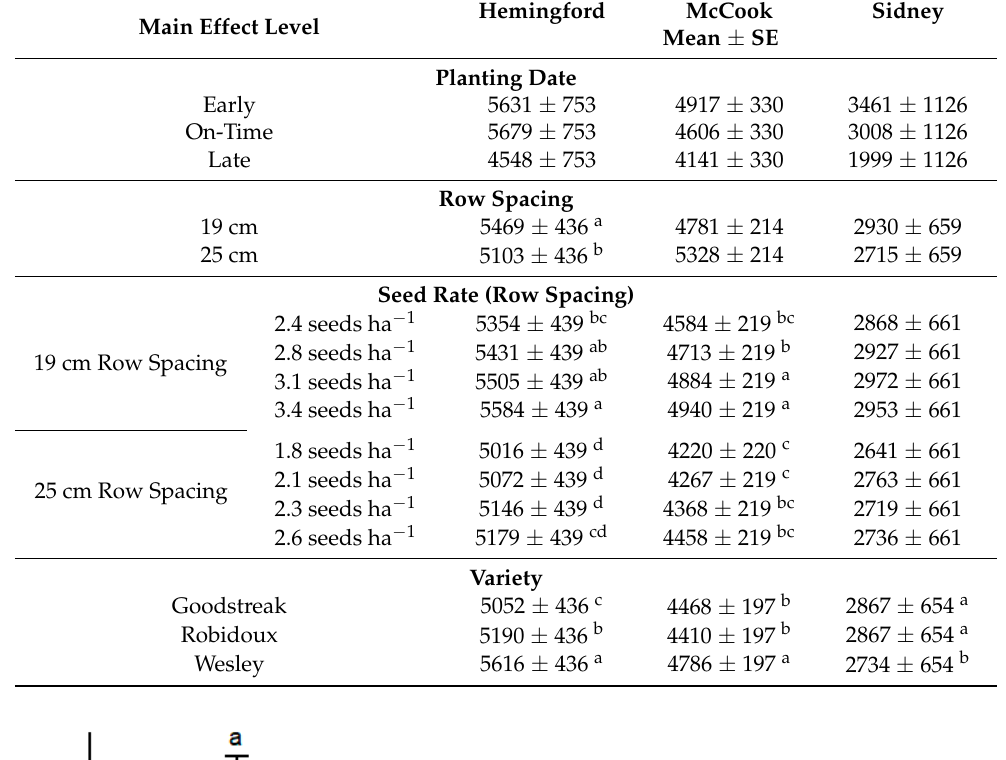
Table 3. Means of main effects, showing significant differences where they exist using letters. Different letters indicate a significant mean difference at p < 0.05. For those groups of means with no designation, the levels of the main effects performed similarly across the experiment.